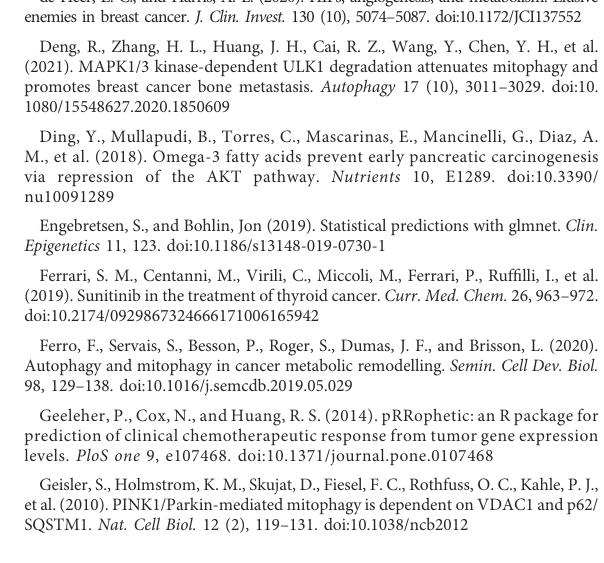
SUPPLEMENTARY TABLE S3 The af fi liation of genes to modules. SUPPLEMENTARY TABLE S4 Hub genes in grey60 module. SUPPLEMENTARY TABLE S5 Enrichment results of hub genes by